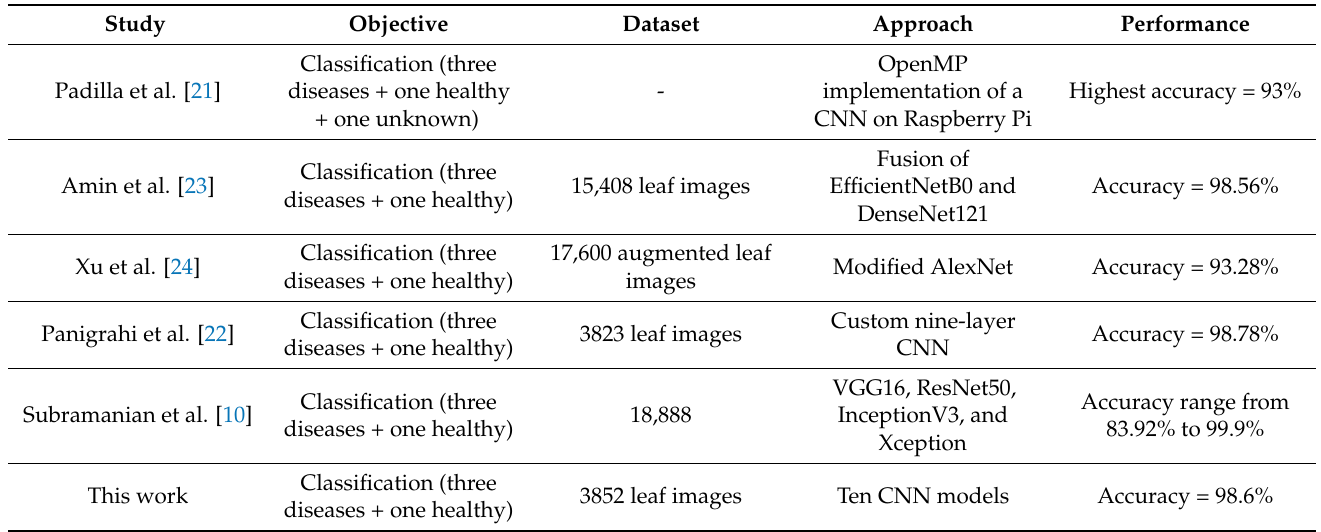
Table 7. A summary of the related literature to identify and classify corn